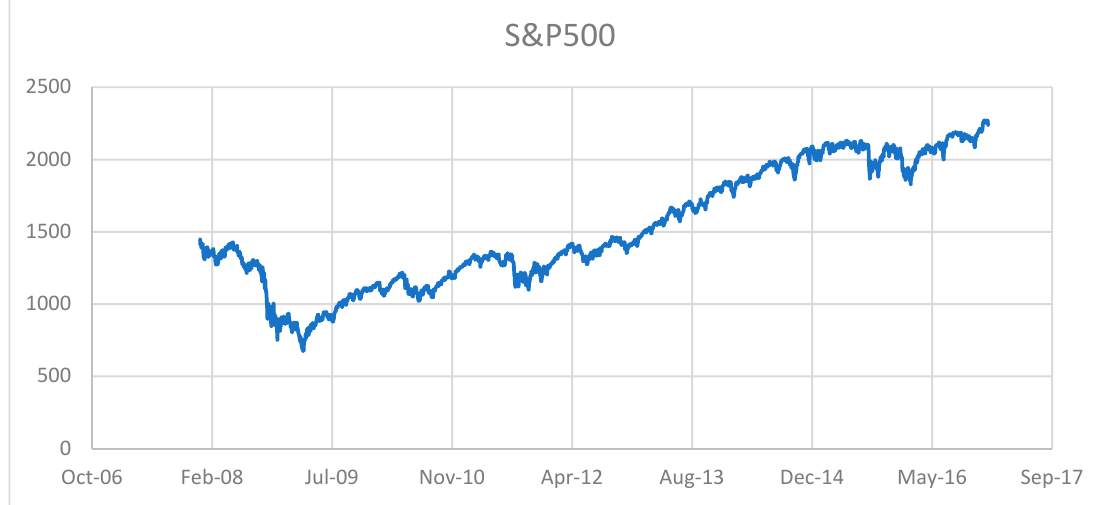
Figure 1. Anxiety and VIX Index. Source: www.investopedia.com/anxiety-index-explained.